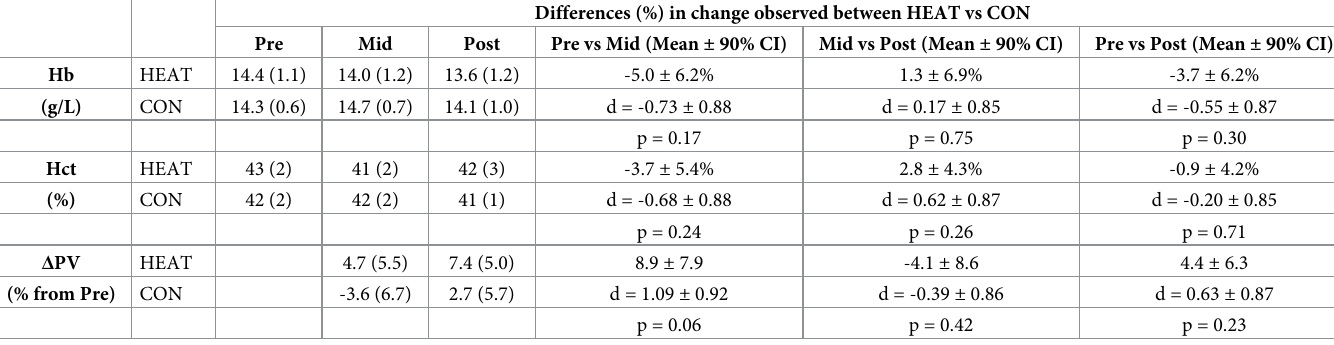
Table 2. Blood Parameter (Hb, Hct and PV) data from Pre, Mid and Post-intervention in HEAT and